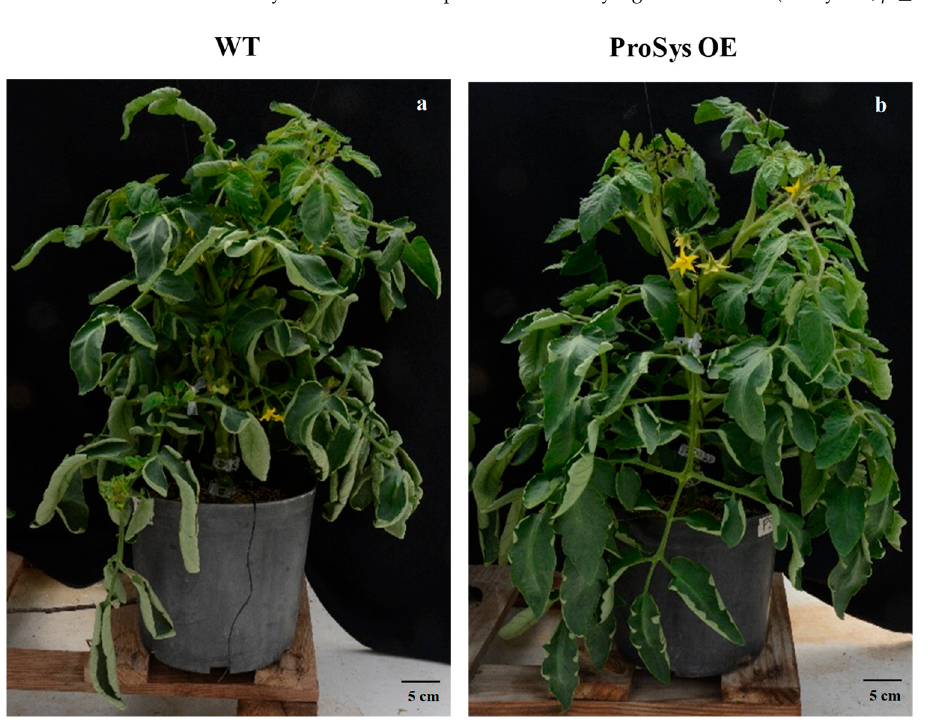
Figure 1. Growth and morphology of prosystemin overexpressing tomato plants. Compared to ( a ) wild-type (WT) untransformed tomato plants, ( b ) plants overexpressing the prosystemin (ProSys- OE) precursor of the systemin peptide hormone had a retarded growth at early developing stages (the images show plants 3 days post transplantation (dpt) into pots). In older plants, recorded 33 dpt, ( c ) WT plants were shorter, had a lower number of leaves and were compacter and morpho- 1 H = plant height; SD = stem diameter; LN = leaf number; LA = total leaf area, BN = bud number, FN, flower logically different to ( d ) ProSys-OE plants. number. 2 Numbers followed by different letters represent statistically significant values (Tukey test, p ≤ 0.05).